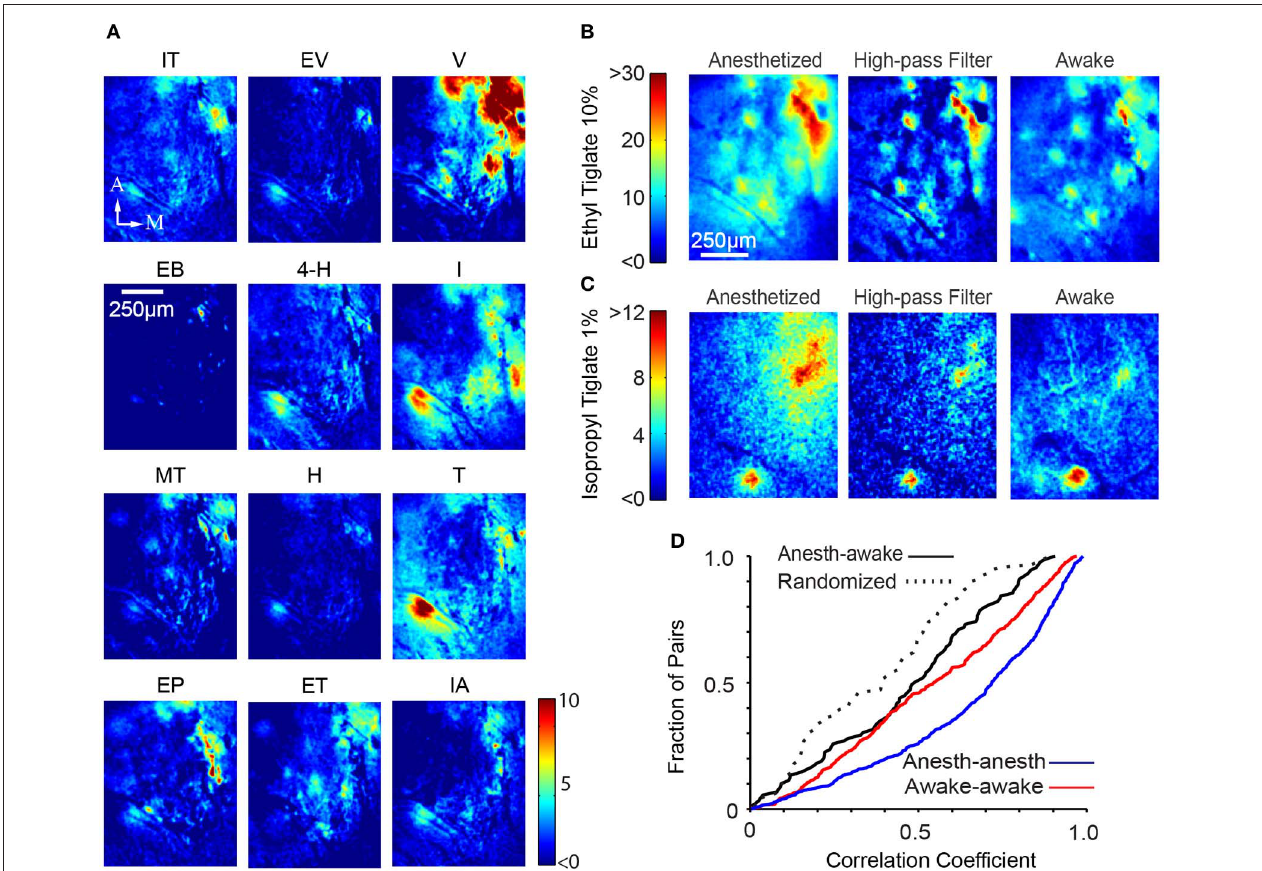
FIGURE 4 | Global glomerular patterns are conserved across behavioral states. (A) Different odors show different response patterns. The images shown are (cid:2) F images of the response of a single awake mouse to 12 different odors, averaged over three trials. IT, Isopropyl Tiglate; EV, Ethyl Valerate; V, Valeraldehyde; EB, Ethyl Butyrate; 4-H, 4-Heptanone; I, Isoamylamine; MT, Methyl Tiglate; H, Heptanal; T, Thiazole; EP, Ethyl Propionate; ET, Ethyl Tiglate; IA, Isoamyl Acetate; M, medial, A, anterior; Scalebar, 250 μ m. (B) Glomerular activation pattern in an anesthetized (left)